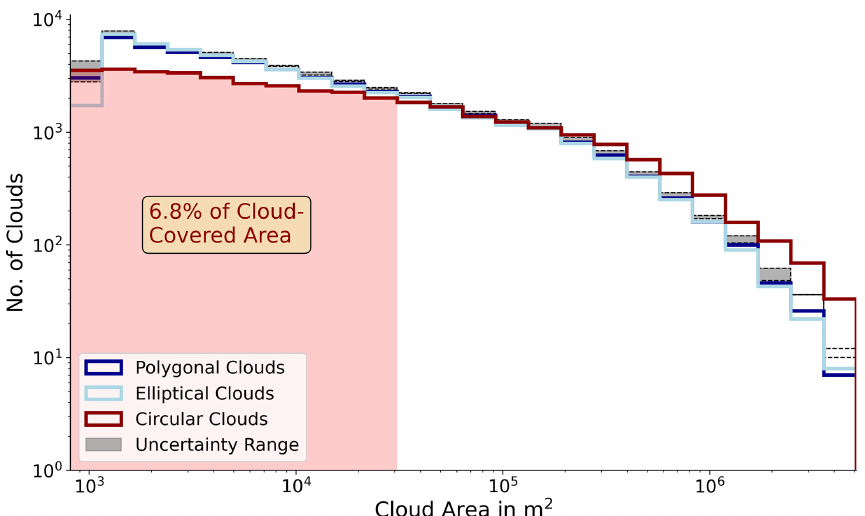
Figure 10. Shallow cloud area size distribution with absolute cloud number (no.) on the y axis. The distributions of polygonal (dark blue), elliptic (light blue), and circular (dark red) clouds based on the along-track length L are compared. The red domain represents the radar subgrid scale. The grey shaded pattern illustrates the variability due to the CTH uncertainty U CTH by adding ± U CTH to each CTH.